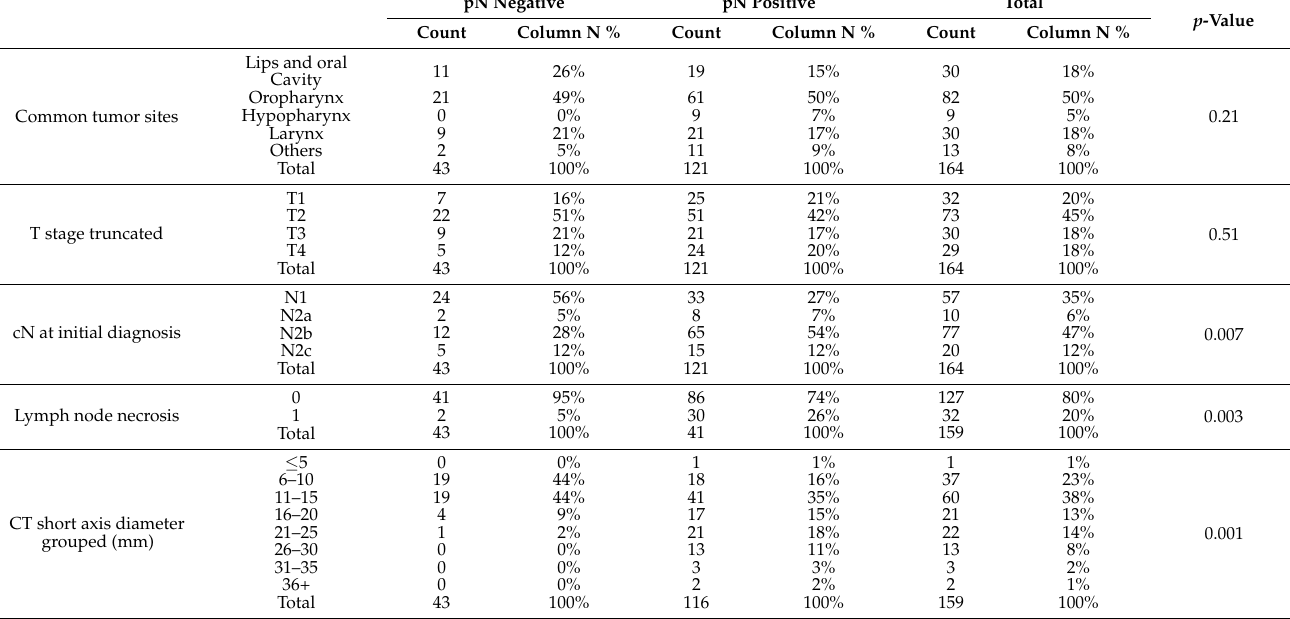
Table 2. Characteristics of cN+/pN0 vs. cN+/pN+ cervical lymph nodes. Characteristics in clinically LN-positive patients by histopathological outcome of neck specimen and chi-square p -values. In- creasing the threshold for clinical lymph node positivity from a short axis diameter of at least 10 mm to at least 15 mm would reduce specificity without better